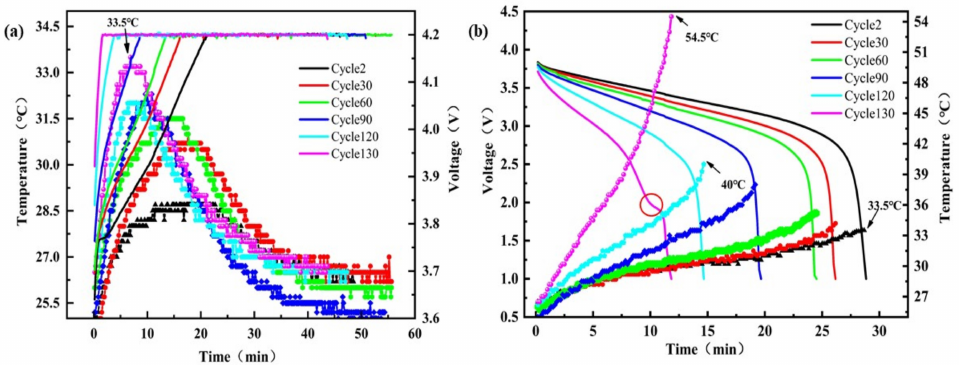
Figure 5. ( a , b ) Voltage and battery surface temperature curve of a -type NCM811 battery during 130 cycles at the cycle ratio of 2 C with the cut-off voltage of 1 V.